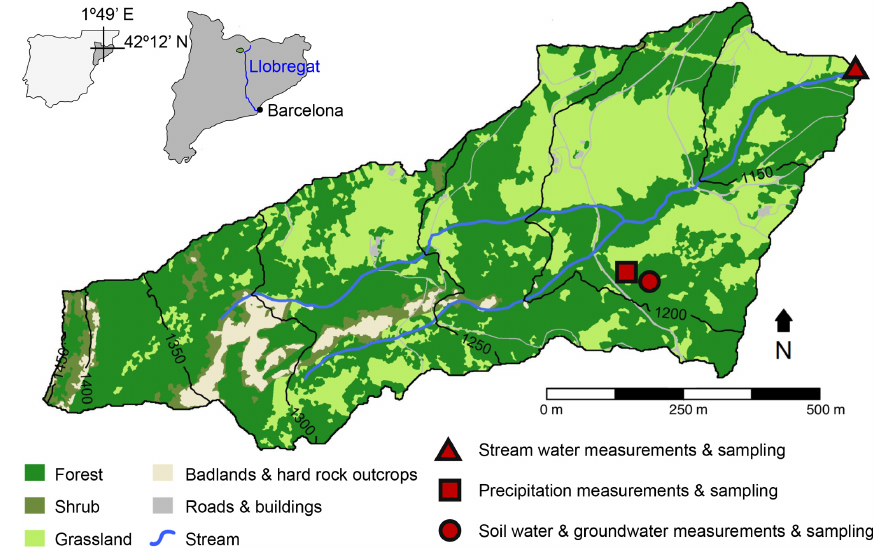
Figure 1. Locations of the hydrometric measurements and the isotope sampling of soil water and groundwater (red circle), precipitation (red square), and stream water (red triangle) within the Can Vila catchment. The elevation is shown using contour lines, and the colors represent land use classes. The inset in the top left indicates the location within Spain (light grey) and Catalonia (dark